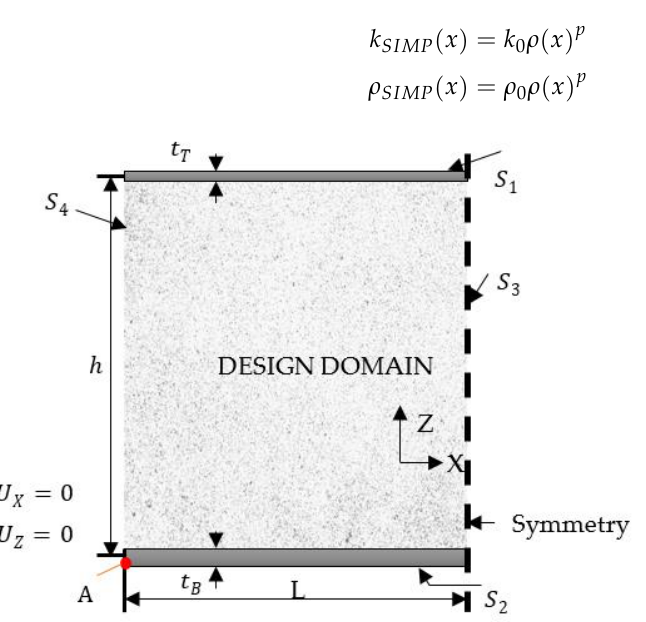
Figure 3. Design domain of ITPS.